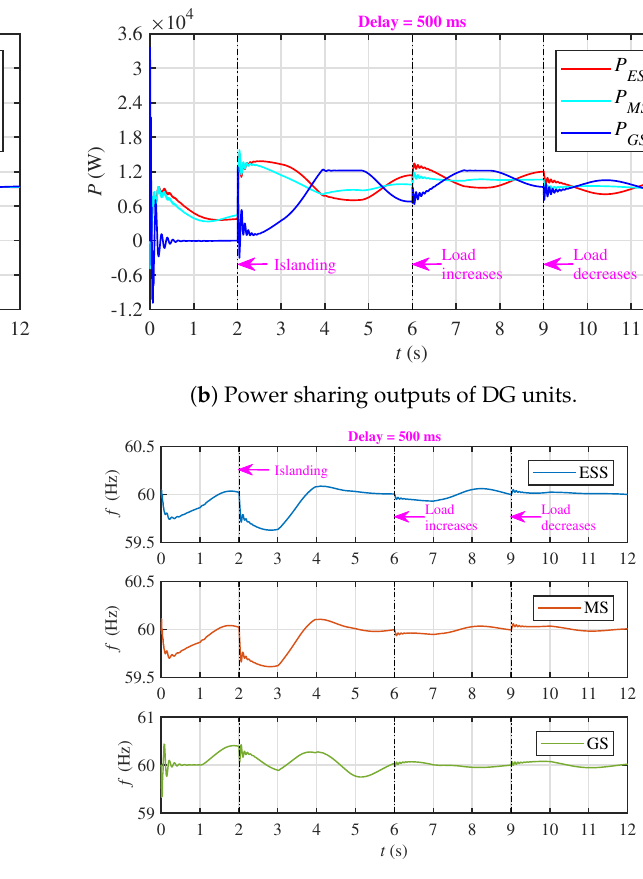
Figure 12. Power sharing outputs and frequency regulation of DG units during plug-and-play operation using the existing protocol, as reported in [35–37].